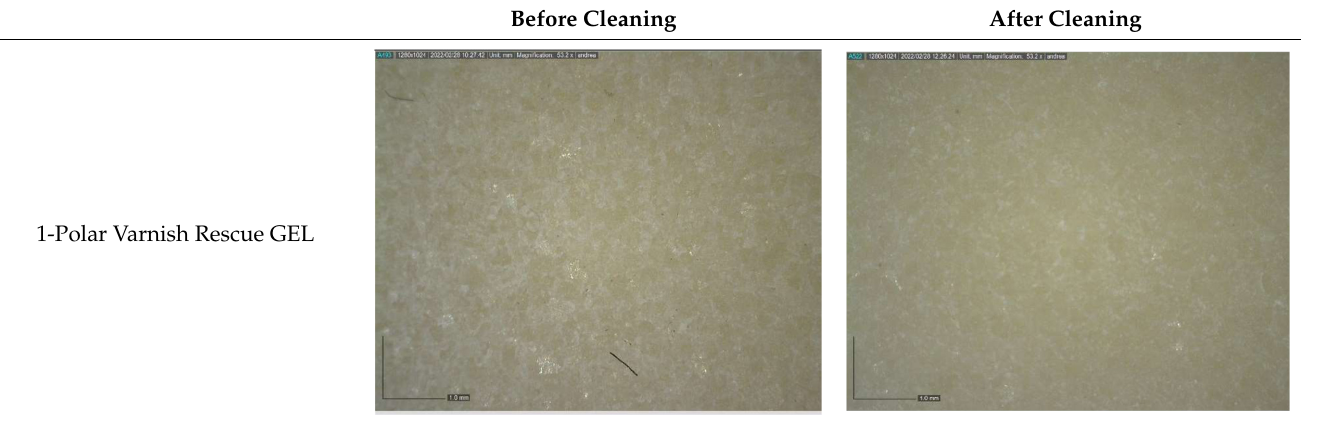
Table 6. Dinolite ® images of the areas before and after treatment.